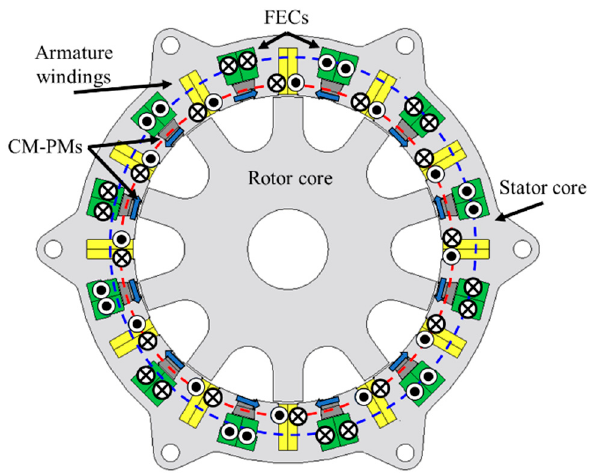
Figure 1. Sectional view of the conventional HEFSM. CM-PM, constantly magnetized-permanent magnets; FEC, field excitation coil. ©2020 IEEE. Reprinted with permission, from K. Otsuka, T. Okada, T. Mifune, H. Matsumori, T. Kosaka and N. Matsui, Proceeding of 2020 IEEE Energy Conversion Congress and Exposition (ECCE), IEEE, 2020.